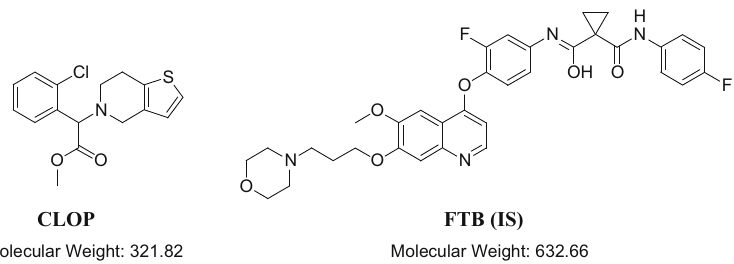
Figure 1: Chemical structures and molecular weights of CLOP and FTB ( IS )